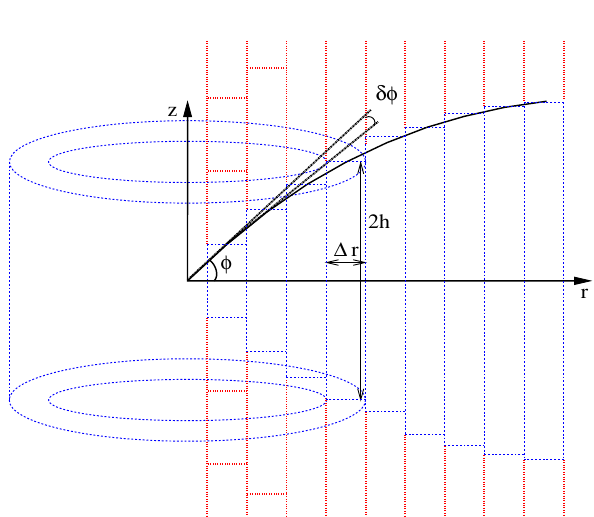
Fig. 1 Illustration of the background field method. The left sketch shows field lines between two masses or charges in flat spacetime. The right panel shows the field lines deformation in spacetime curved by a background field. In this article, the mass deforming spacetime is the total galactic mass and the effect on the field lines connecting two parts of the galaxy is determined by using the standard gravitational lensing formalism